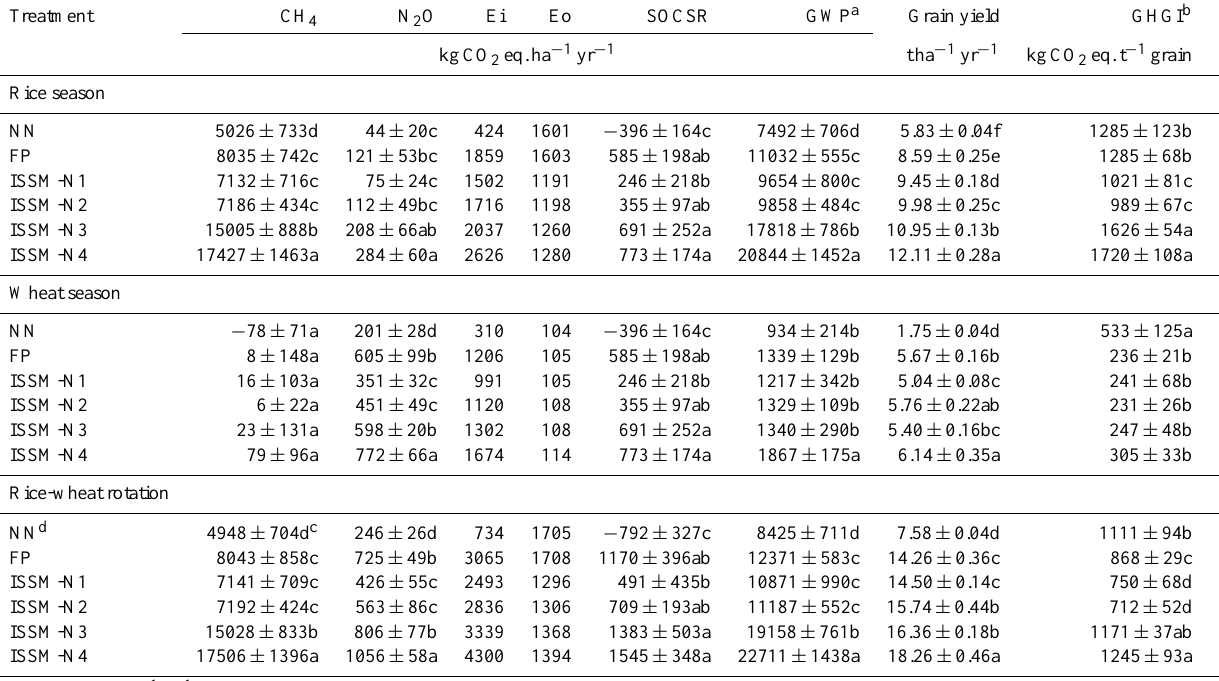
Table 6. Mean global warming potential (GWP) and greenhouse gas intensity (GHGI) over the three rice season, wheat season and annual cycles of the 2011 rice season–2014 wheat